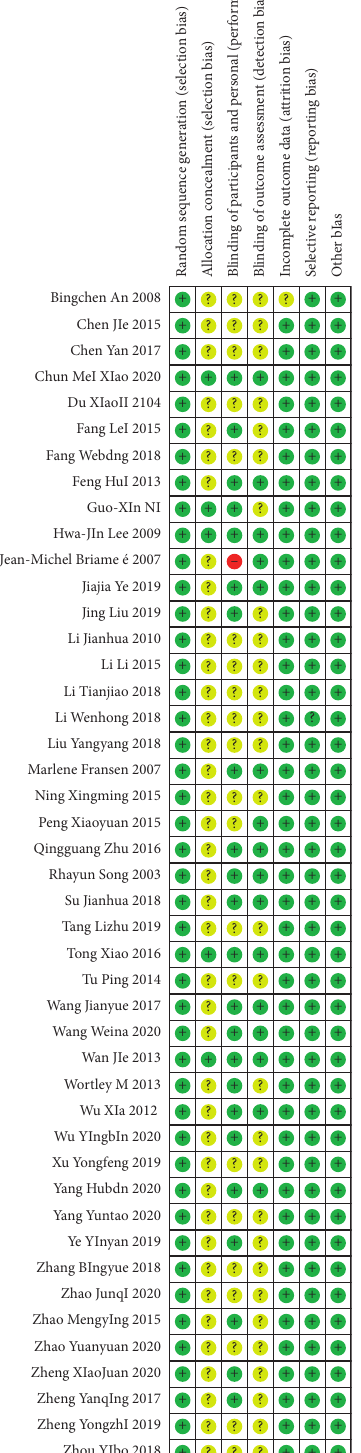
Figure 10. WOMAC index of the three-funnel chart and metabias regression analysis shows no publication bias.